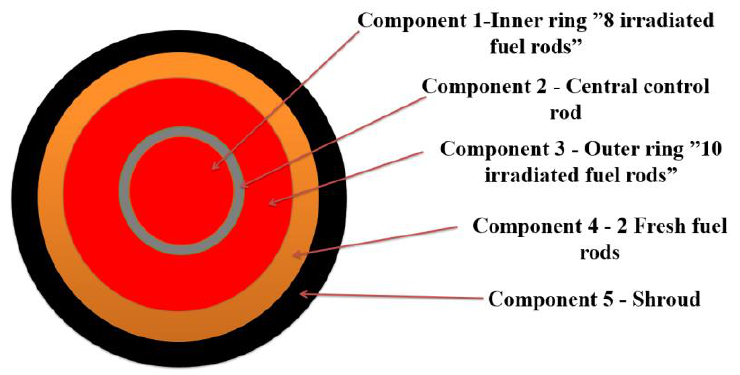
Figure 5. Schematic view of radial nodalization of SCDAP part which models PHEBUS FPT-1 test bundle.